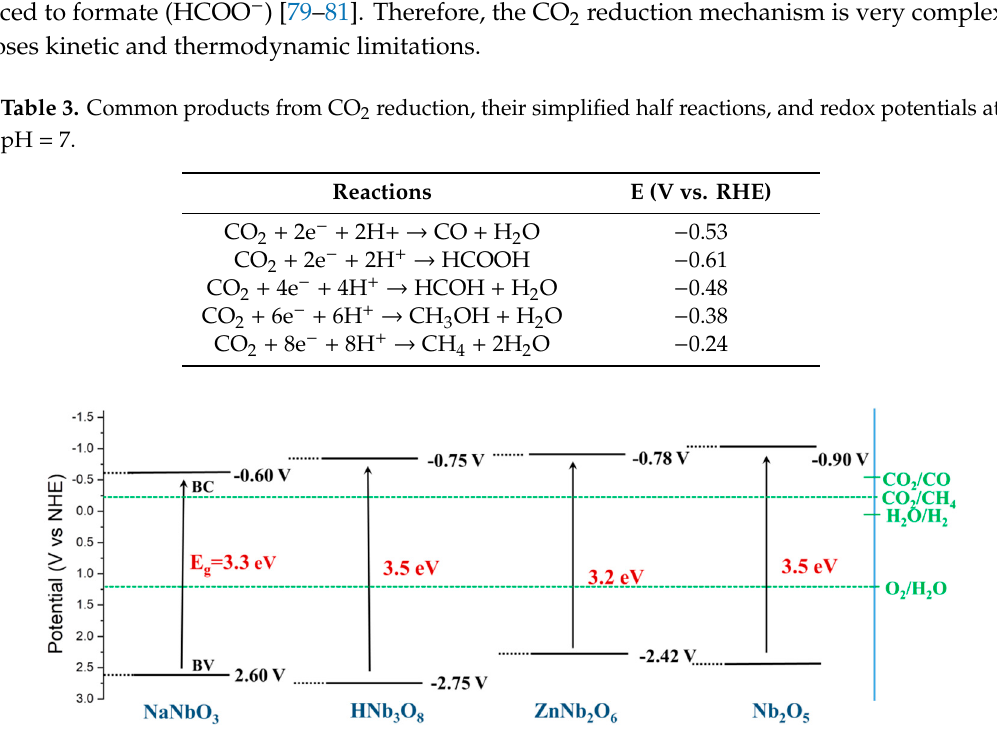
Figure 13. Band gap (Eg) and band positions of Nb-based semiconductors vs. normal hydrogen electrode (NHE). On the right side, the standard potentials of several redox couples are presented for comparison.